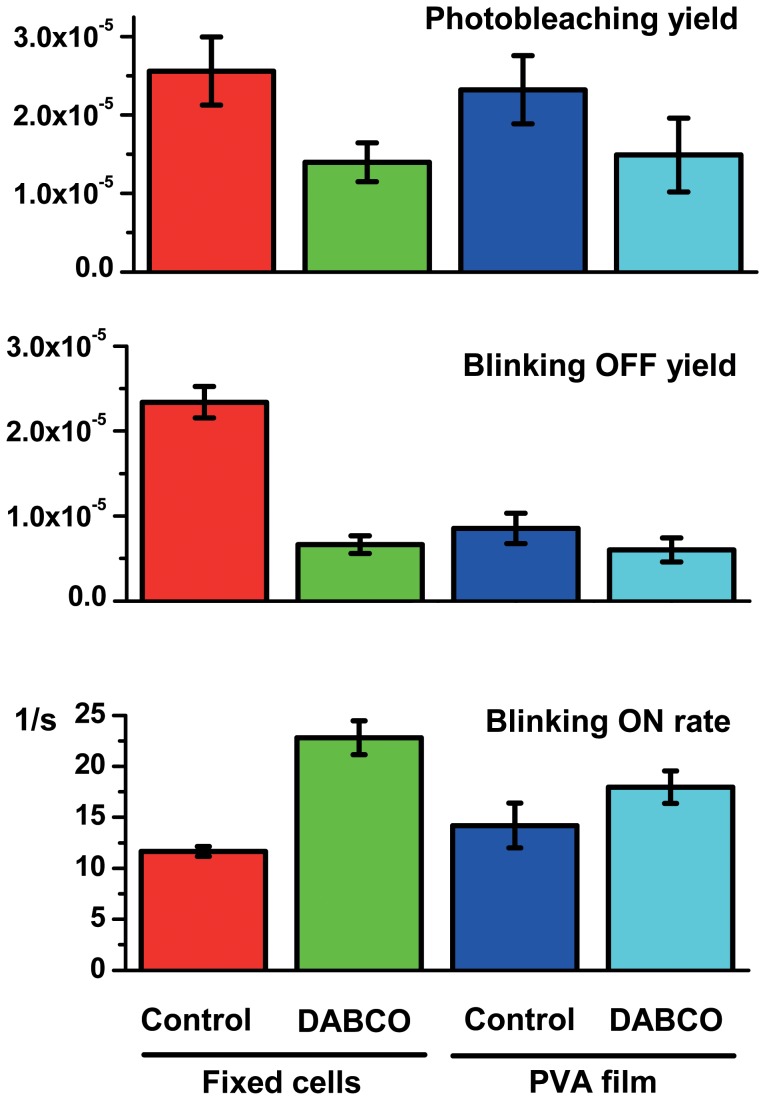
Phototransformation yields of Dendra2-actin expressed in mammalian cells and purified Dendra2 embedded into PVA film.Error bars indicate standard deviations. Number of samples per experiment n = 3–5. Cell samples are from different batches prepared independently.